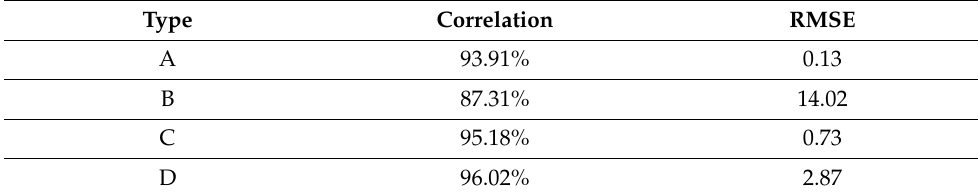
Table 3. Performance of the optimal ARIMA model (training